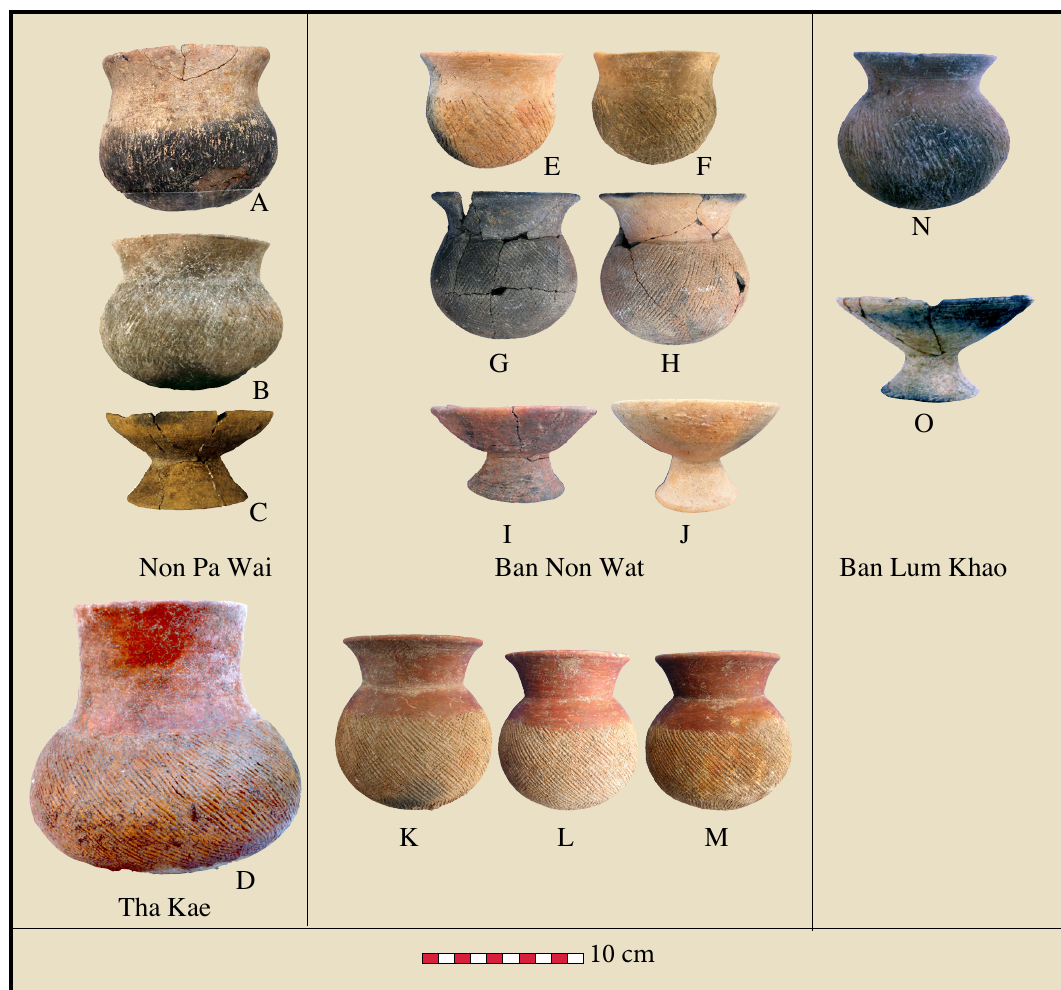
Fig. 6: Early Bronze Age vessels from the Lopburi area and the Upper Mun Valley, showing common forms and